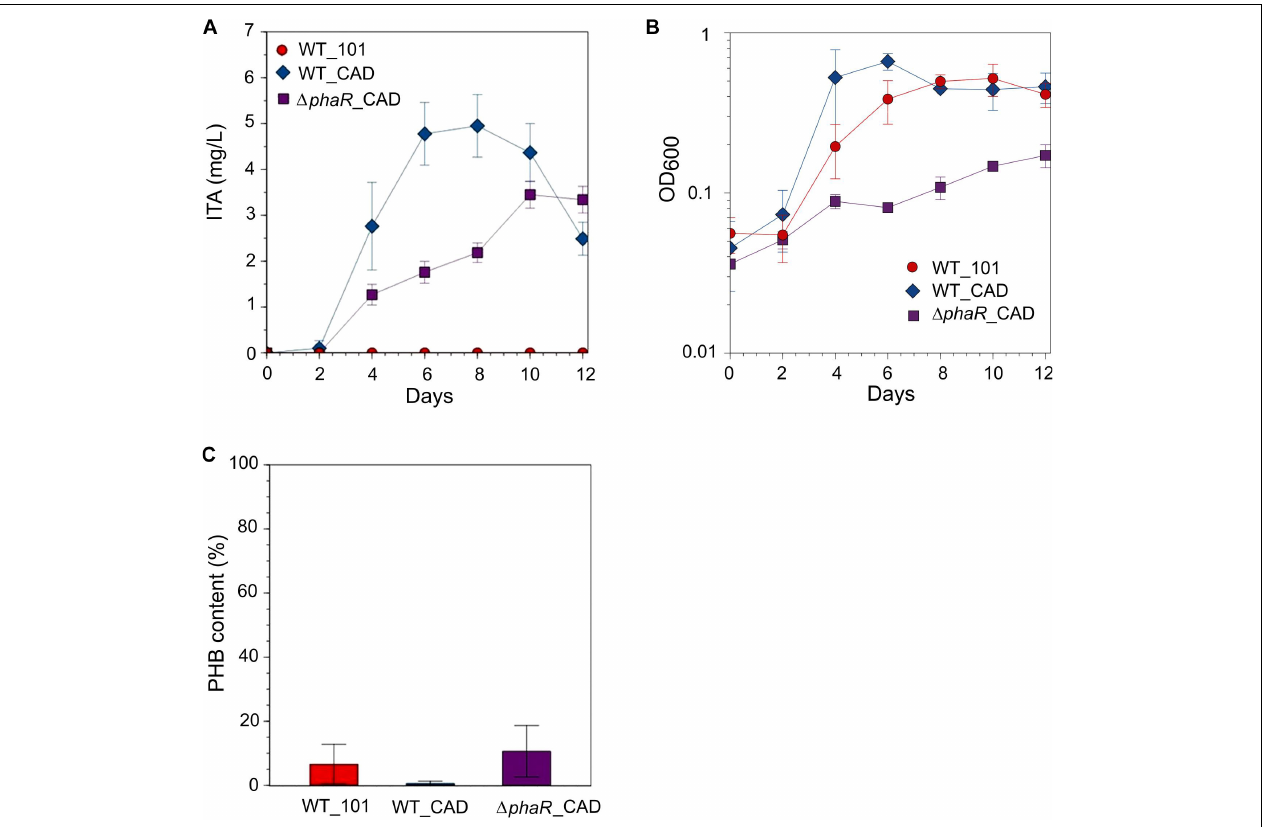
FIGURE 3 | Strains grown in HM medium supplemented with 30 mM sodium acetate as the carbon source. (A) ITA concentration, (B) OD 600 and (C) PHB content (PHB weight/cell dry weight) was measured on day 12 after acetate was mostly consumed. A statistically significant difference (Student’s t -test, p < 0.05) was observed in peak ITA concentration between WT_CAD (day 8) and (cid:49) phaR _CAD (day 10). No statistical significant difference (Student’s t -test) was observed in PHB content between the strains. Error bars represent one standard deviation.